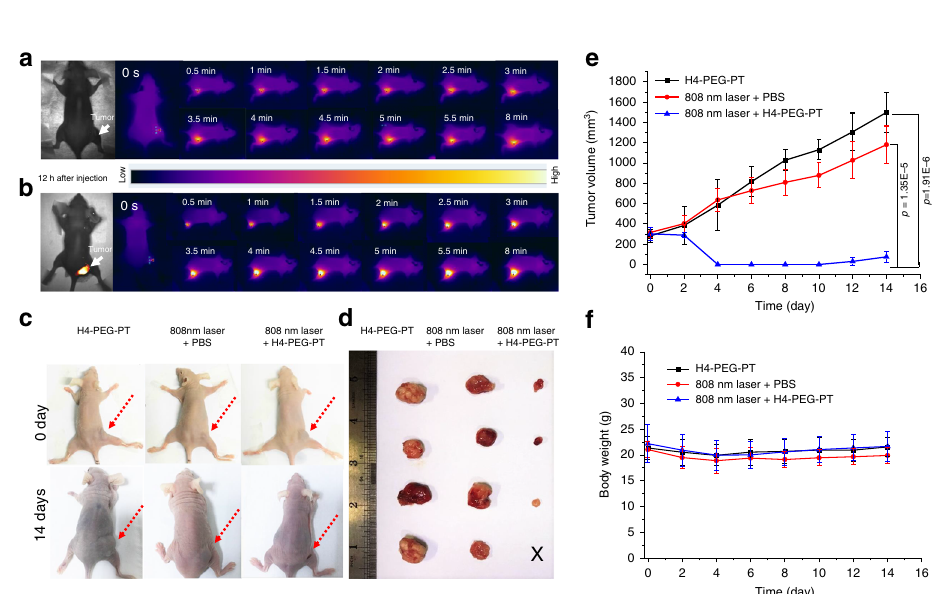
Fig. 9 In vivo photothermal evaluation of H4-PEG-PT against osteosarcoma. a PBS and b H4-PEG-PT solution injected to tumor bearing mice under 808 nm laser irradiation (1.5Wcm − 2 ). c Representative photographs of mice after different treatments: H4-PEG-PT only, PBS under 808nm laser irradiation, and H4-PEG-PT exposed to 808nm irradiation, respectively. Red dashed arrows indicated tumor. d Photographs of tumor tissue obtained in different groups after 14 d treatment, respectively. e Tumor volumes and f body weight of different groups of 143B tumor-bearing mice after treatment ( n = 4 biologically independent mice). Data are presented as mean values±SD ( e , f ). Statistical signi fi cance was calculated with two-tailed Student ’ s t test ( e